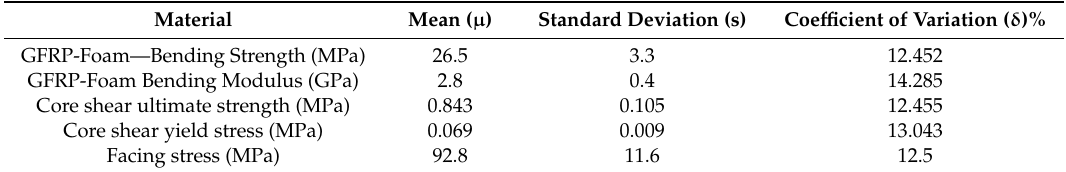
Table 2. Statistical indicators determined from the tests at static three-point bending of GFRP-foam specimens.